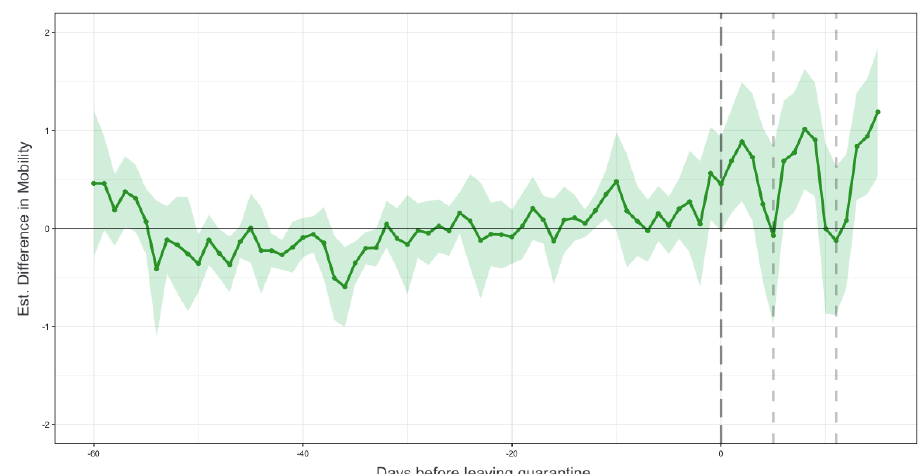
Figure 14. Estimation of the effect of lifting the quarantine on mobility in low-income communes of the Metropolitan